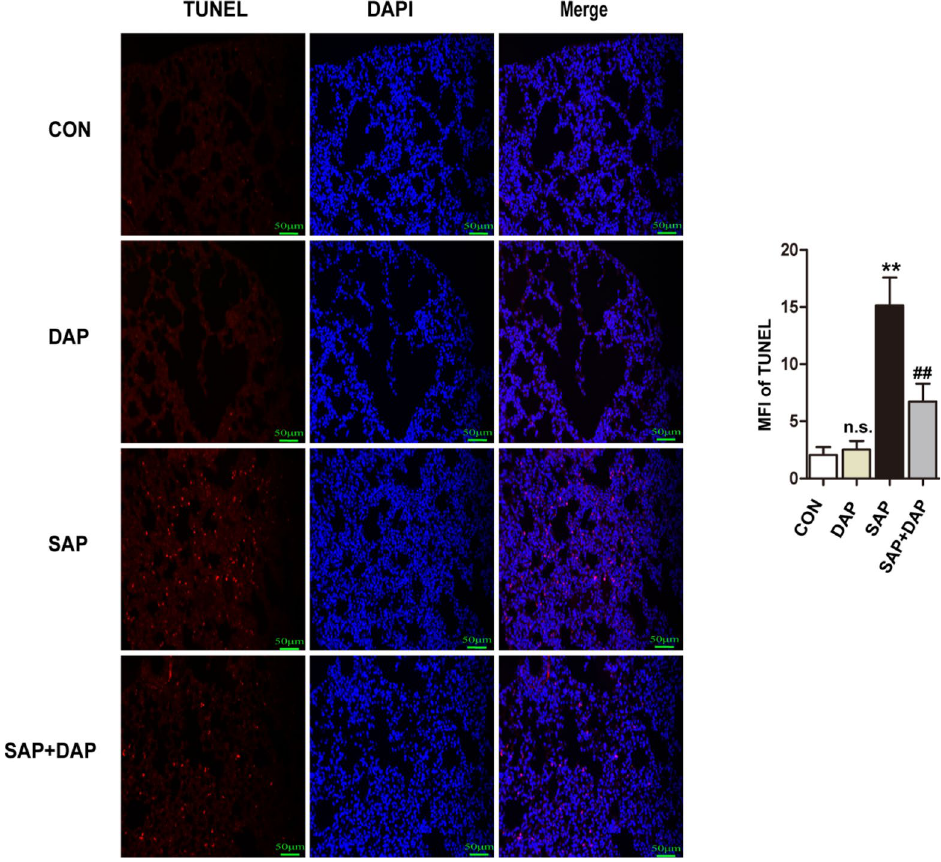
Figure 4. Daphnetin Pretreatment Inhibited the Apoptosis in Lung Tissues. Representative images of immunofluorescence detection of the apoptosis markers of TUNEL in the lung tissues. Nuclei were counterstained with DAPI. The results for the quantitation of mean fluorescence intensity (MFI) in the red channel are presented. The histograms were created using GraphPad 5 software(GraphPad Prism 5.01 http:// www. xdowns. com/ soft/ xdown s2009. asp? softid= 49668 & downid= 60& id= 52443). The quantitative analysis of immunostaining was used by ImageJ software(Image J 2 system software https:// imagej. net/ Downl oads). CON group, l-arginine vehicle + daphnetin vehicle; SAP group, l-arginine + daphnetin vehicle; DAP group, l-arginine vehicle + daphnetin; SAP + DAP group, l-arginine + daphnetin. Data are presented as the mean ± SD. n = 6/ group. ** P < 0.01 versus CON group. ## P < 0.01 versus SAP group, n.s. P > 0.05 vs. CON group. Scale bars: 50